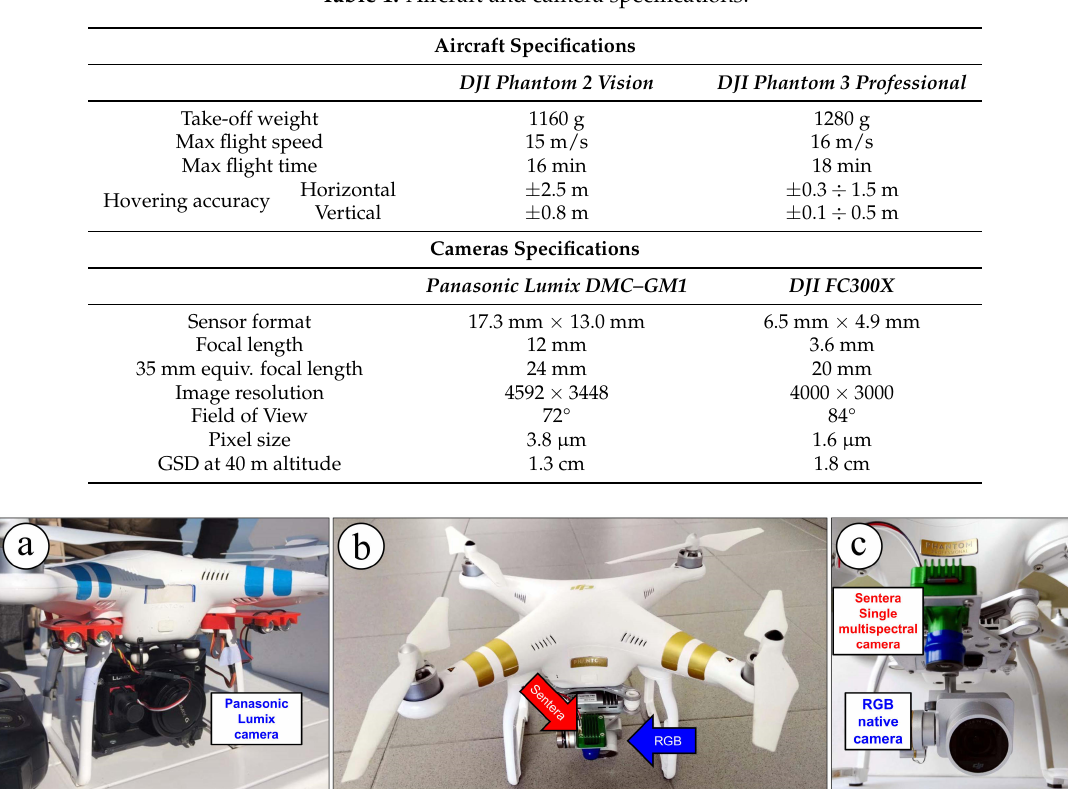
Table 1. Aircraft and camera specifications.